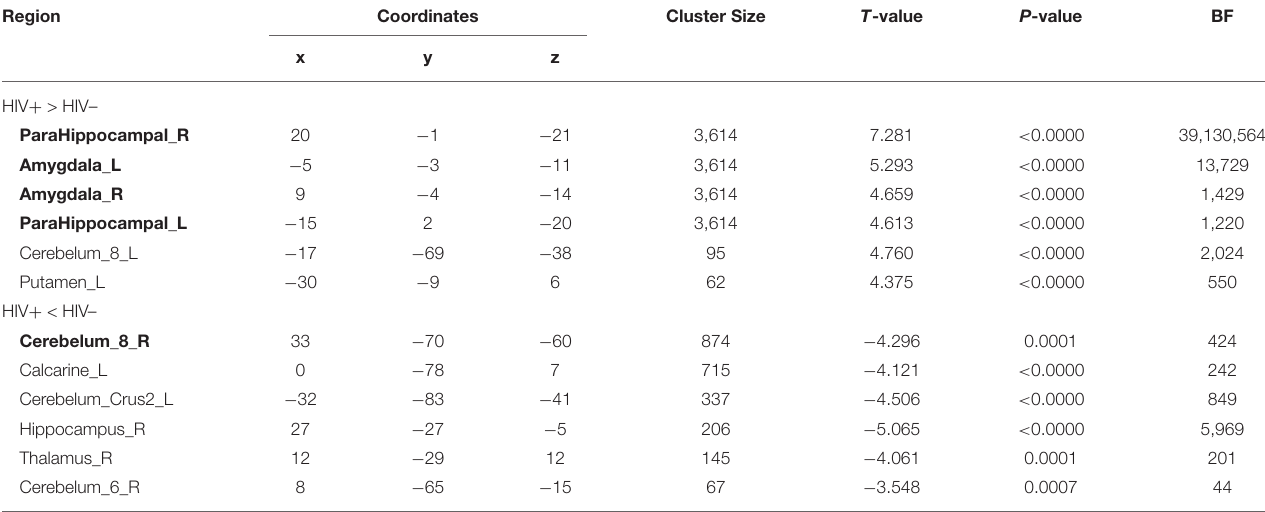
TABLE 2 | Gray matter volume differences between HIV + HoM and HIV– HoM. Region Coordinates Cluster Size T -value P -value BF